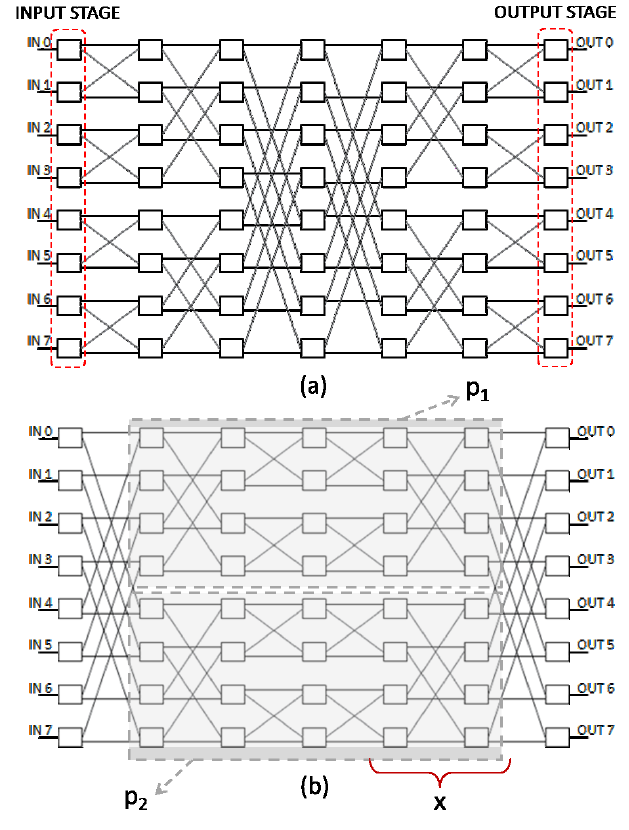
Figure 3. An N × N (with N = 8) flat version of the proposed MSSN: original architecture ( a ) and rearrangeably non-blocking (RNB)-proof unicast topologically equivalent version ( b